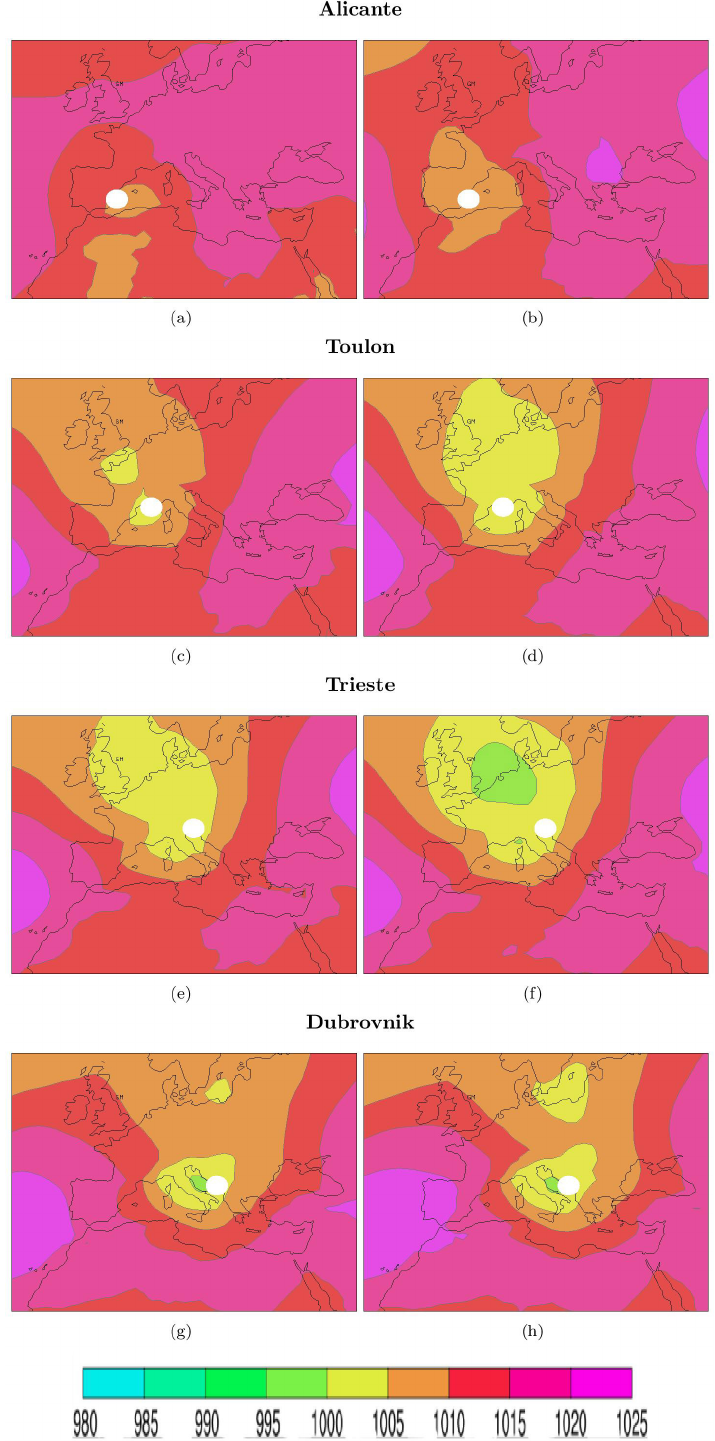
Figure 2. Composite of ERA-Interim SLP fields (values in hPa) associated with large positive sea level anomalies in Alicante (a, b) , Toulon (c, d) , Trieste (e, f) and Dubrovnik (g, h) , denoted with white circles in the maps. The right and left column show composites based on the COSMO-ERA hindcast (MOD) and in the observed time series (OBS), respectively. Each composite is based on a total number of 100 events, obtained by selecting the largest events in the 1979–2001